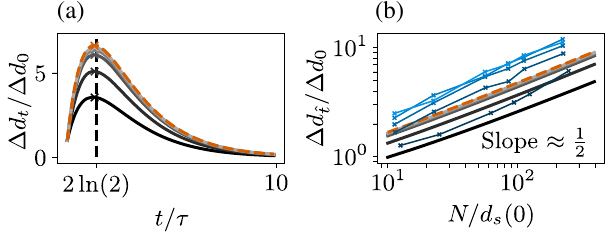
FIG. 8. Optimal expansion within 2 ln 2 neuronal activations. (a) Effective dimension Δ d ð t Þ (27) relative to initial Δ d ð 0 Þ for 0 Þ ↘ 0 . Maxima at vanishing initial noise amplitude d ffiffiffiffiffiffiffiffiffiffiffiffiffiffiffiffiffiffi n ð ˆ 0 Þ =d d (A28) marked by s ð (cid:3) crosses. The time to maximum for weak initial stimuli δ ≪ 1 is well approximated by ˆ t ≃ 2 ln 2 τ (vertical dashed line). From dark to light gray: g ¼ 0 . 5 , 1, 2, 3, 5 and tanh gain function; dashed dark orange curve, Heaviside gain function, limit g → ∞ . 0 Þ ¼ 200 . (b) Maximal effective dimen- Initial parameter N=d s ð 0 Þ . sion Δ d ð ˆ t Þ relative to initial Δ d ð 0 Þ as a function of N=d s ð Same color code as (a). In blue, corresponding simulation results averaged over ten connectivity seeds each and corrected for the probability that a noise realization does not leave the original flux tube; see the Appendix 10 c. Values of g from dark to light as in